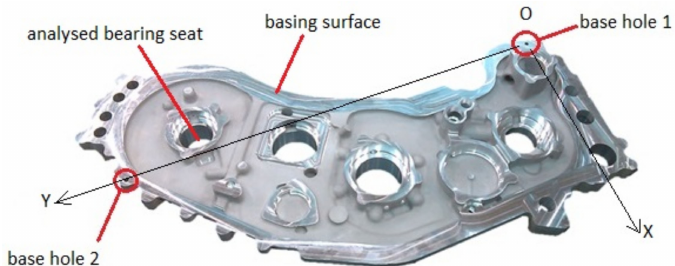
Figure 6. Base face of the cover (on the circumference) constituting the measuring reference surface—bottom